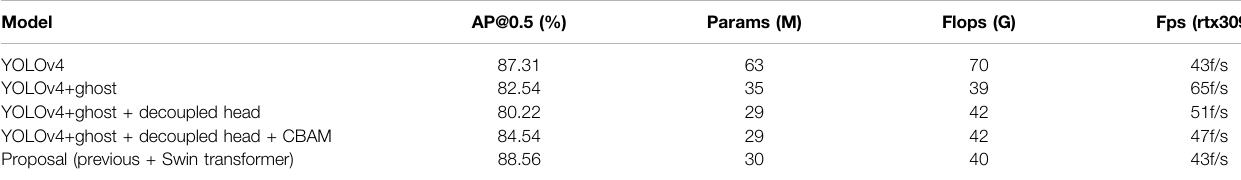
TABLE 3 | Ablation study result.